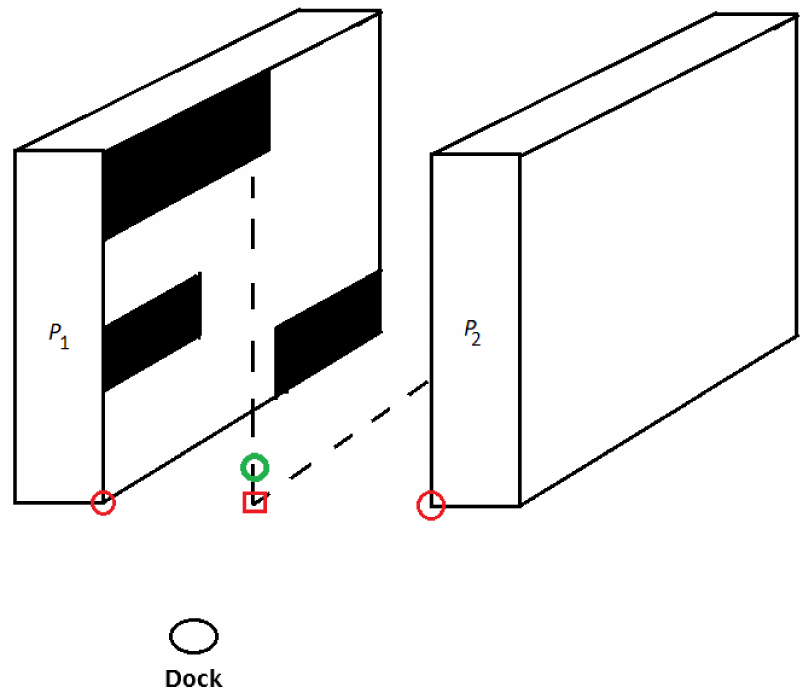
Figure 4. The shelving system to be tested. Black shelves indicate compartments that have already been checked. The green circle is the start position of the examination, the red square is the center of the corridor (reference point). The red circles are reference points. (Source: self-edited